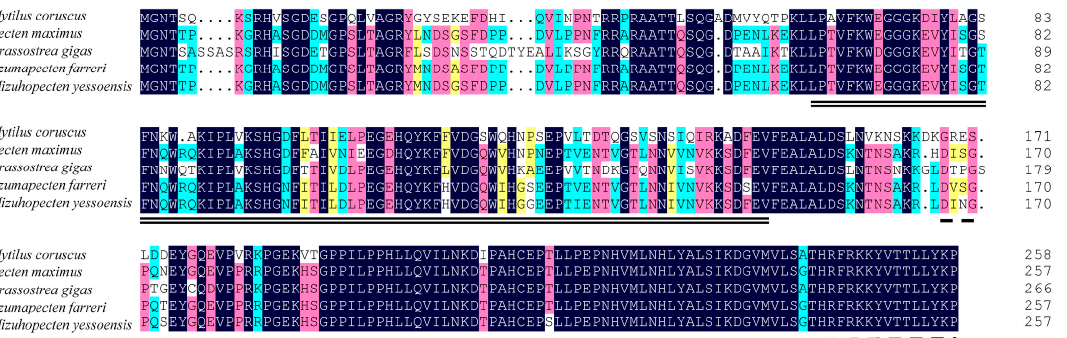
Figure 6. The multiple sequence alignment of McAMPK β with other mollusks. The double underline area represents the CBM domain. The dashed line area represents the AMPKBI domain. The accession number of the AMPK β sequence used: Pecten maximus (XP_033735434.1), Crassostrea gigas (XP_011450446.2), Azumapecten farreri (QFR39801.1), and Mizuhopecten yessoensis (XP_021357013.1). The predicted McAMPK γ protein shares a high sequence identity with Mytilus galloprovincialis (98.24% similarity), Pecten maximus (64.55% similarity), Mizuhopecten yessoensis (63.48% similarity), and Crassostrea gigas (59.24% similarity) (Figure